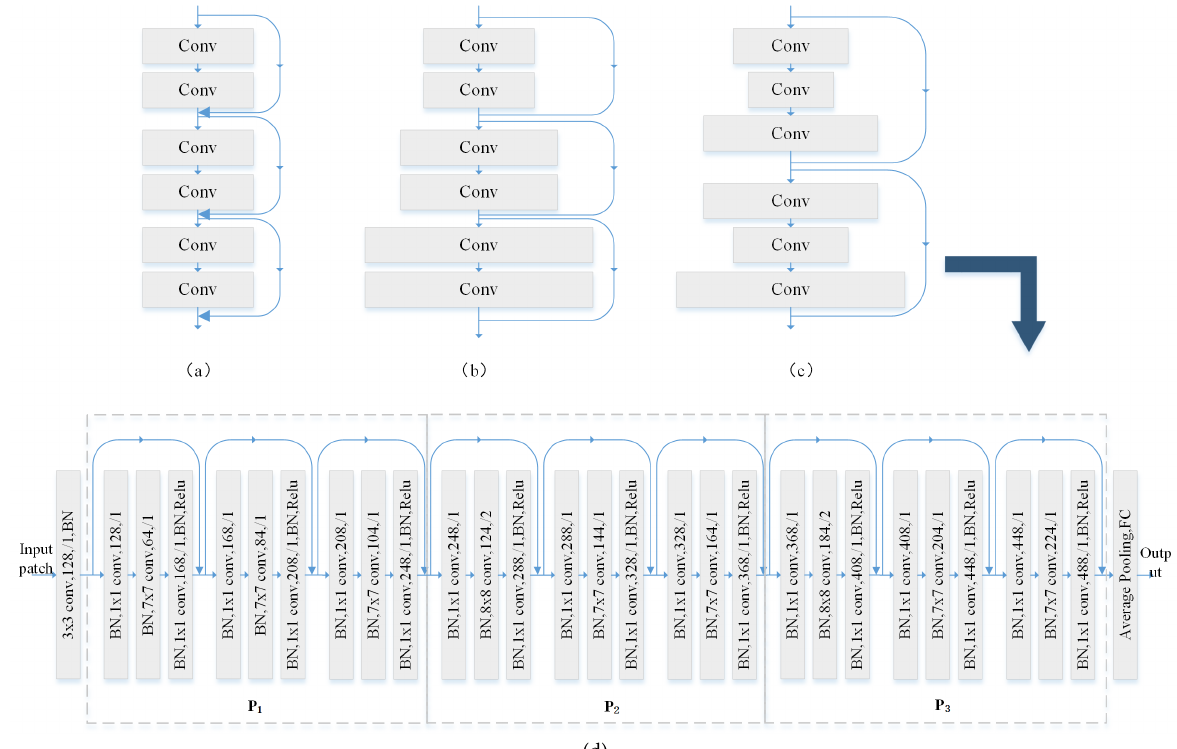
Figure 3. Different residual cells and deep bottleneck pyramid neural network used for ground classification to exact the oilseed rape cultivation area. ( a ) Traditional residual unit. ( b ) Bottleneck residual unit. ( c ) Pyramid residual unit. ( d ) Pyramid residual network architecture. The kernel size, depth, and stride are listed in turn for each convolutional layer. BN denotes the batch normalization. Relu denotes the rectified linear unit for activation. FC denotes the fully connected layer, and “conv” denotes the convolutional